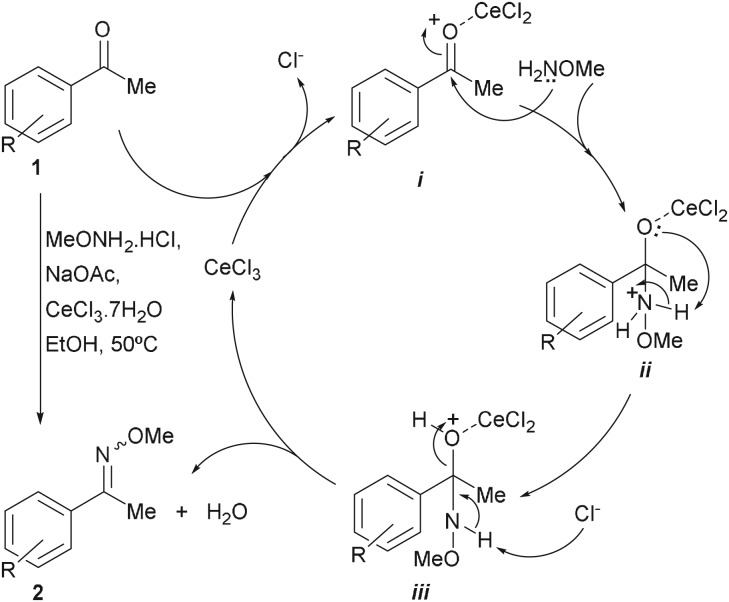
Proposed reaction mechanism for the catalytic cycle of the CeCl3·7H2O-promoted methoximation of aromatic aldehydes and ketones.